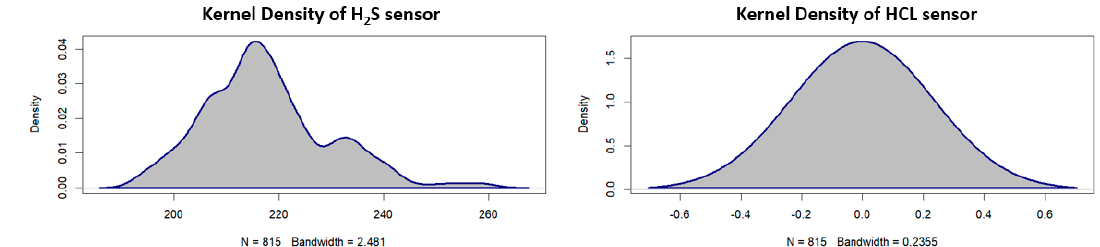
Figure A8. Kernel density for UAV measurement (PM 1.0 sensor, PM 2.5 sensor, PM 10 sensor, C X H Y sensor).